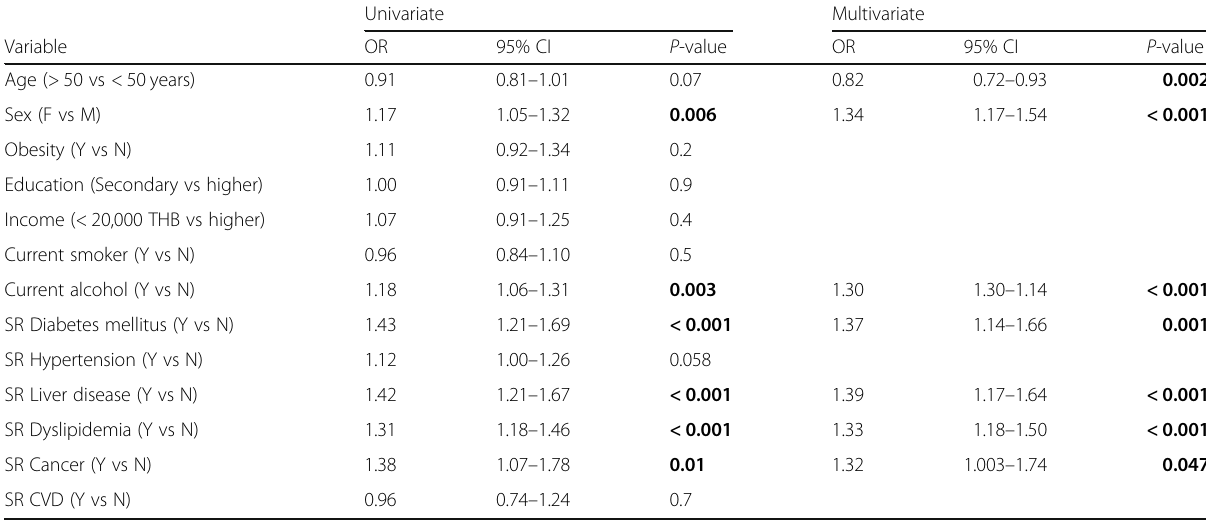
Table 2 Factors associated with Herbal and Traditional Medicine use Univariate Multivariate